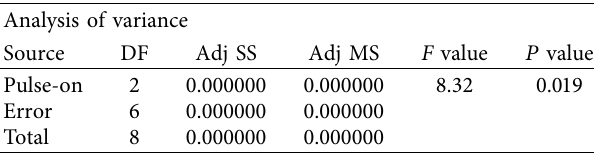
Table 9: One-way ANOVA: MRR vs. pulse-on time for aluminium.